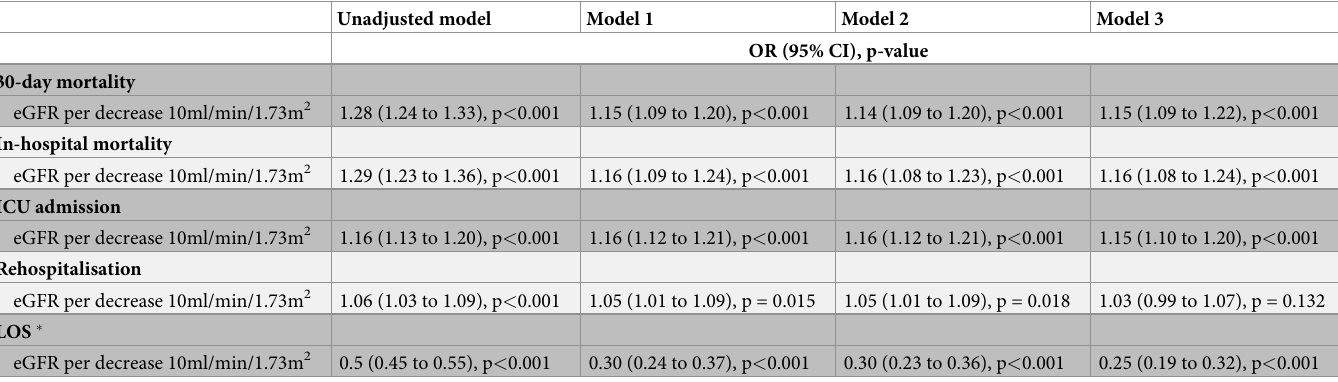
Table 3. Univariate and multivariate logistic regression analyses according to continuous eGFR